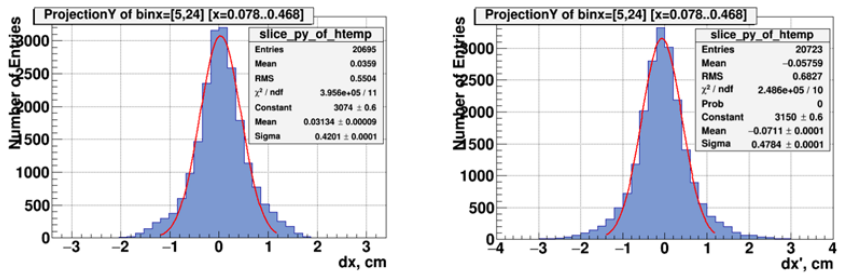
Figure 5. CSC X and Y hit residuals: magnetic field switched o